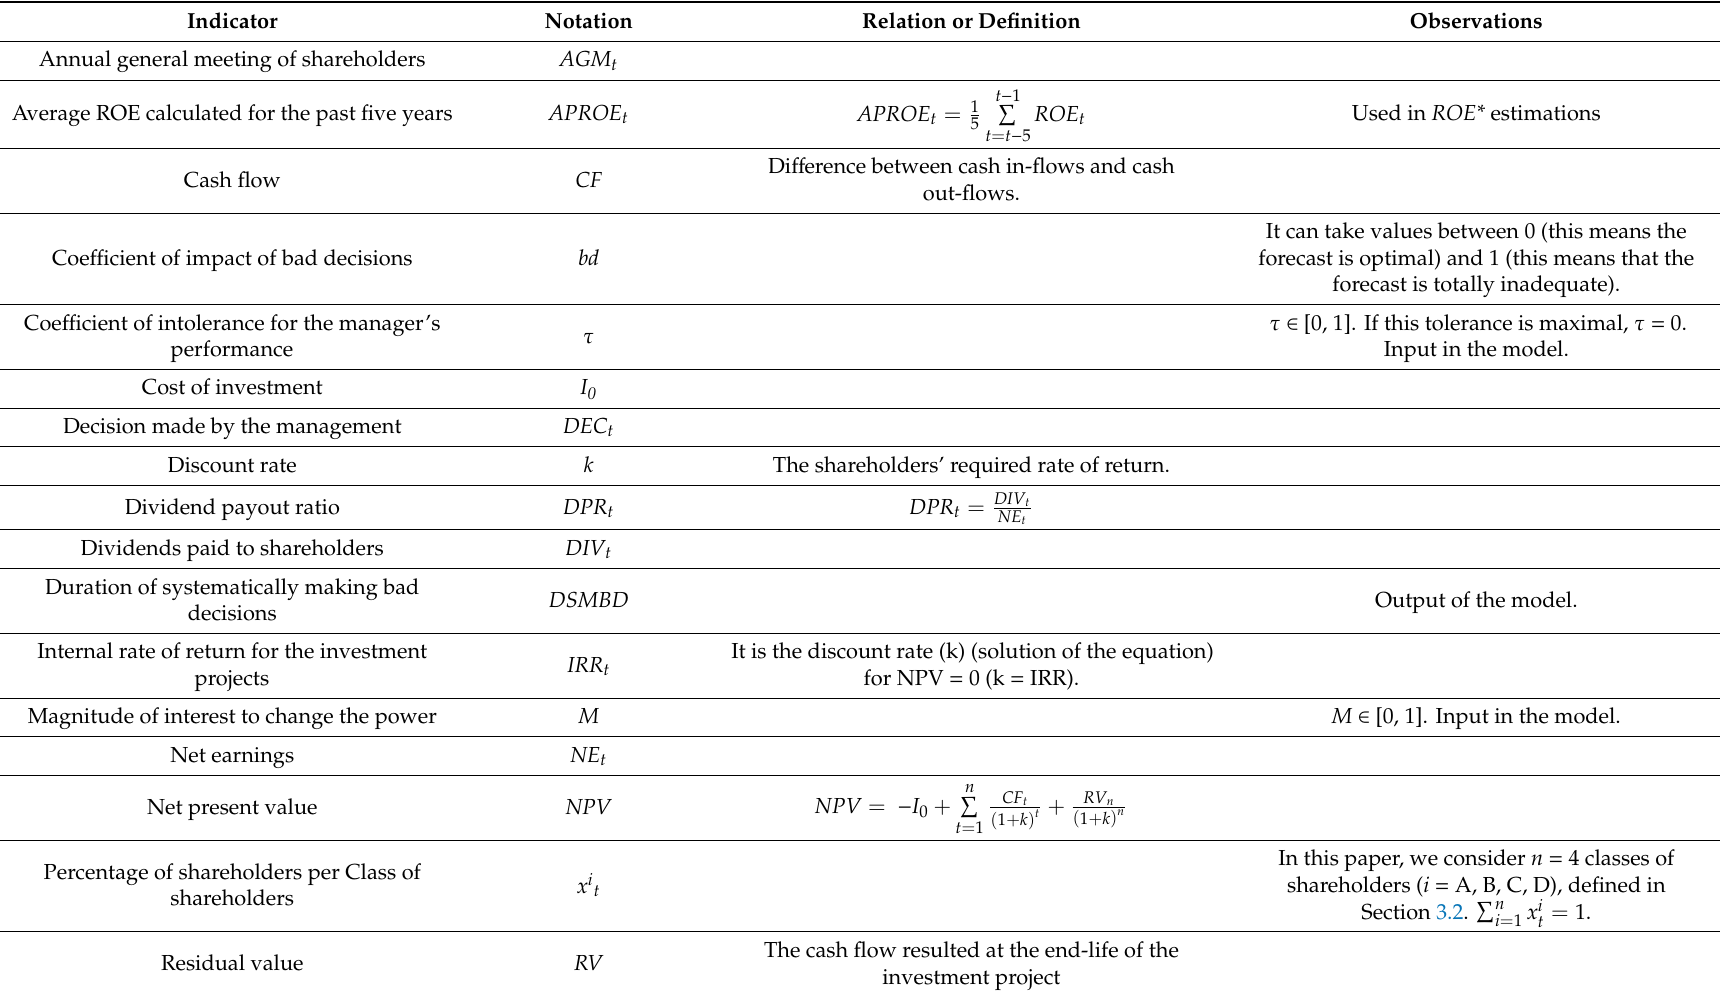
Table 1. Notations used in the